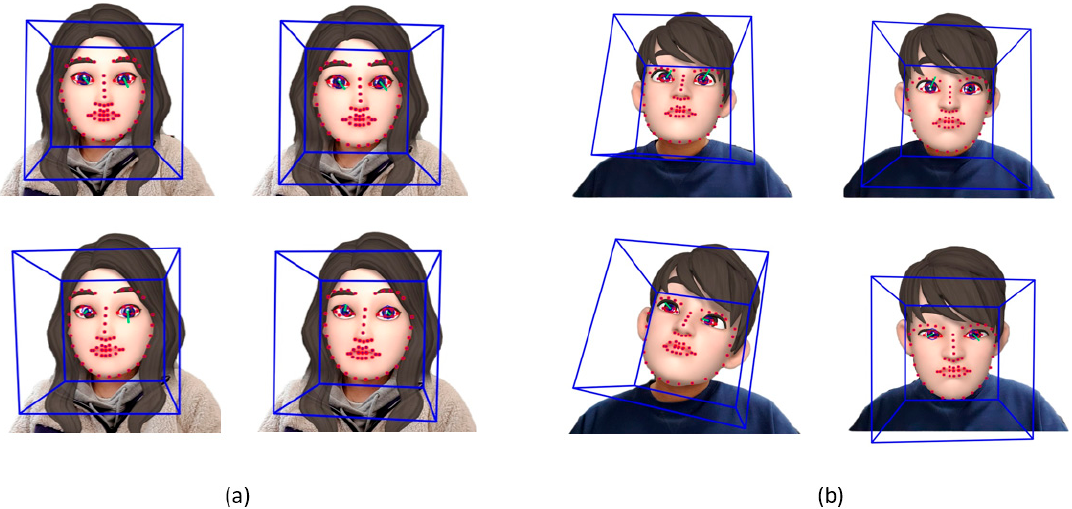
Figure 6. Extracted facial landmarks: ( a ) normal group and ( b ) AD group.